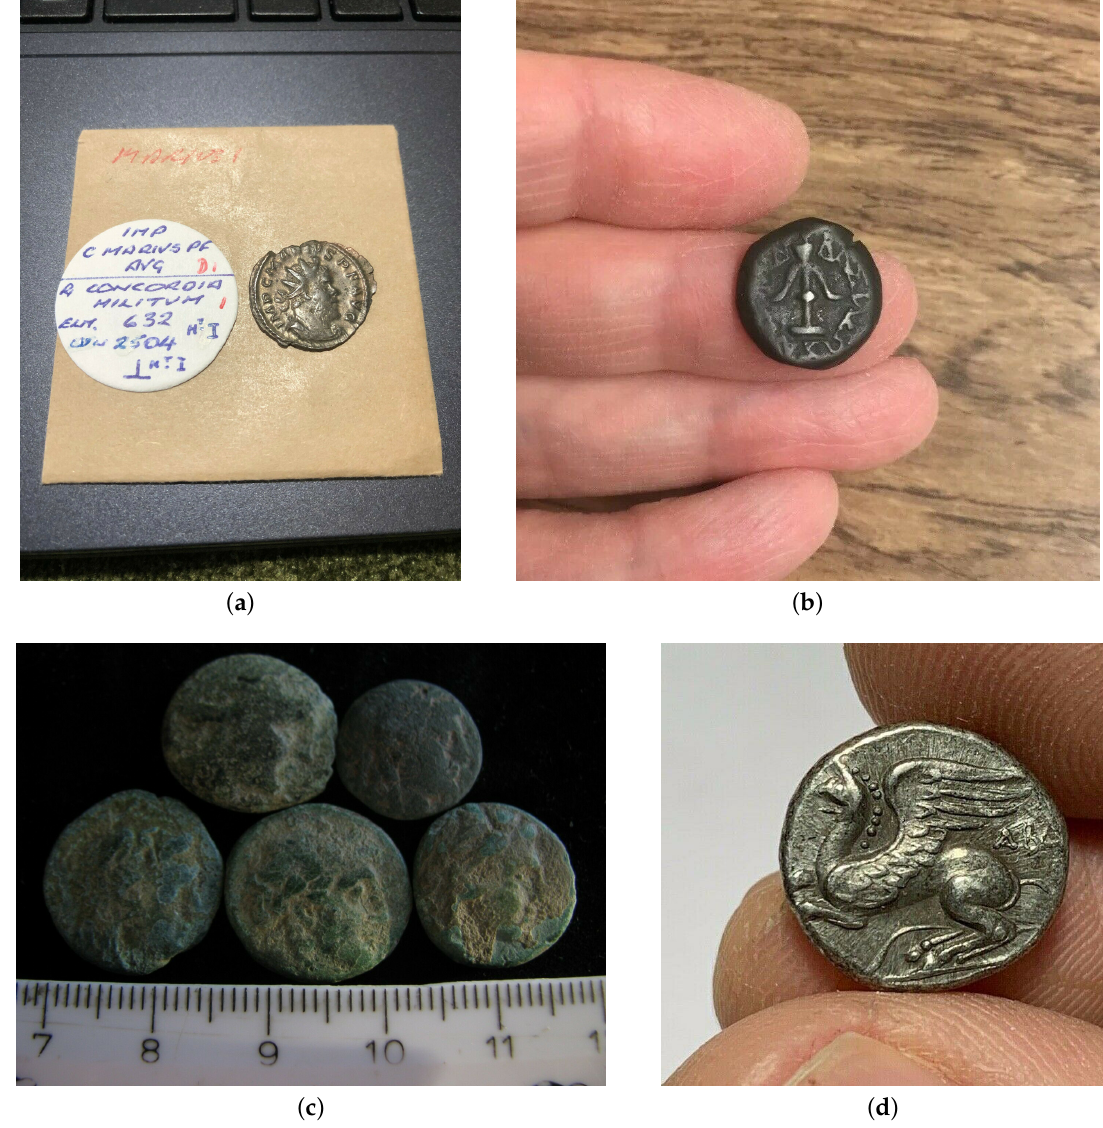
Figure 6. Most ancient coins are sold by private individuals—the non-professional imaging setup used introduces a series of additional confounds and challenges, such as background clutter, poor illumination, partial occlusion, etc. as illustrated on real-world examples ( a – d